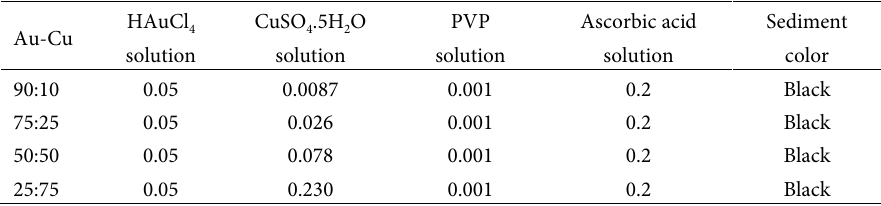
Table 1. Au-Cu Precursor Solutions with Different Ratios